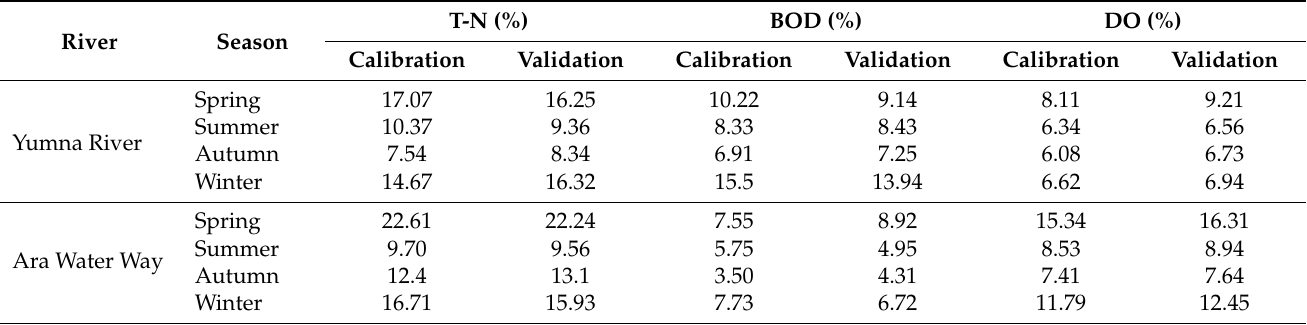
Table 1. Fitting level assessment of the WASP8 outcomes with MAPE process.